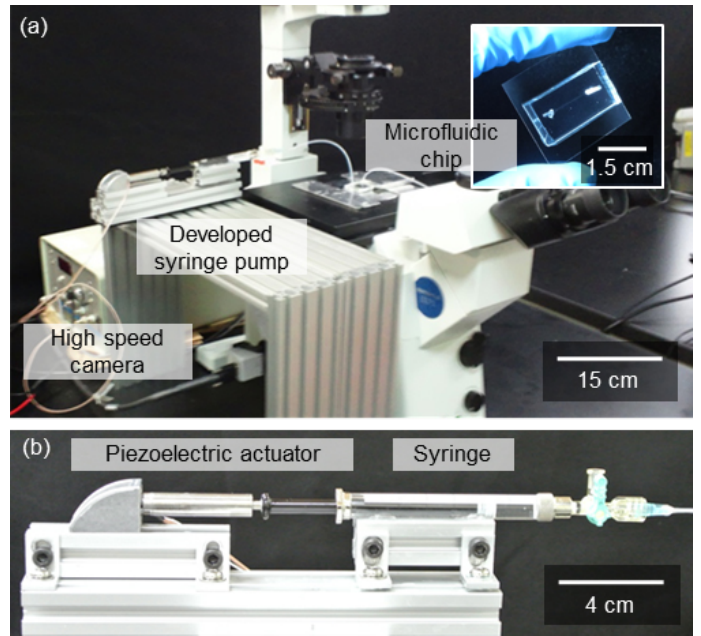
Figure 3. The developed cell positioning system. ( a ) An overview of the system and ( b ) the developed syringe